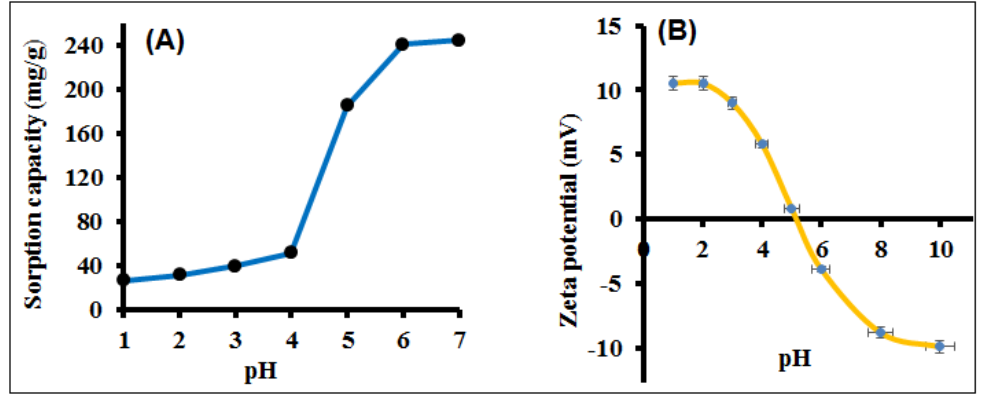
Figure 7. ( A ) Effect of sample pH on the adsorption of Hg(II); ( B ) zeta potential of PANI-MOS